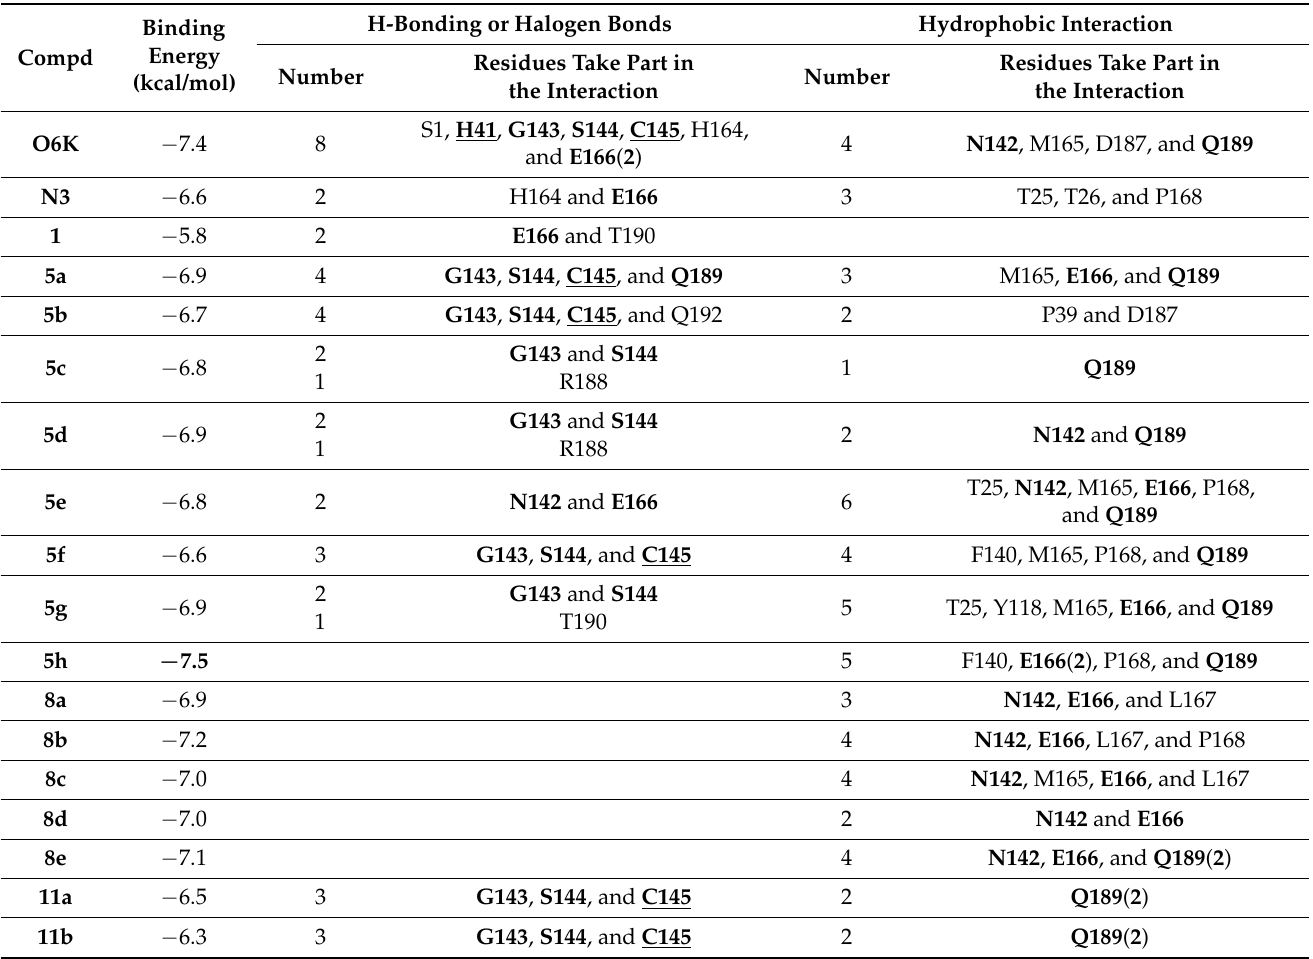
Table 1. The interaction pattern of the compounds ( 1 , 5a – h , 8a – e , and 11a , b ) and the positive control O6K against SARS-CoV-2 M pro